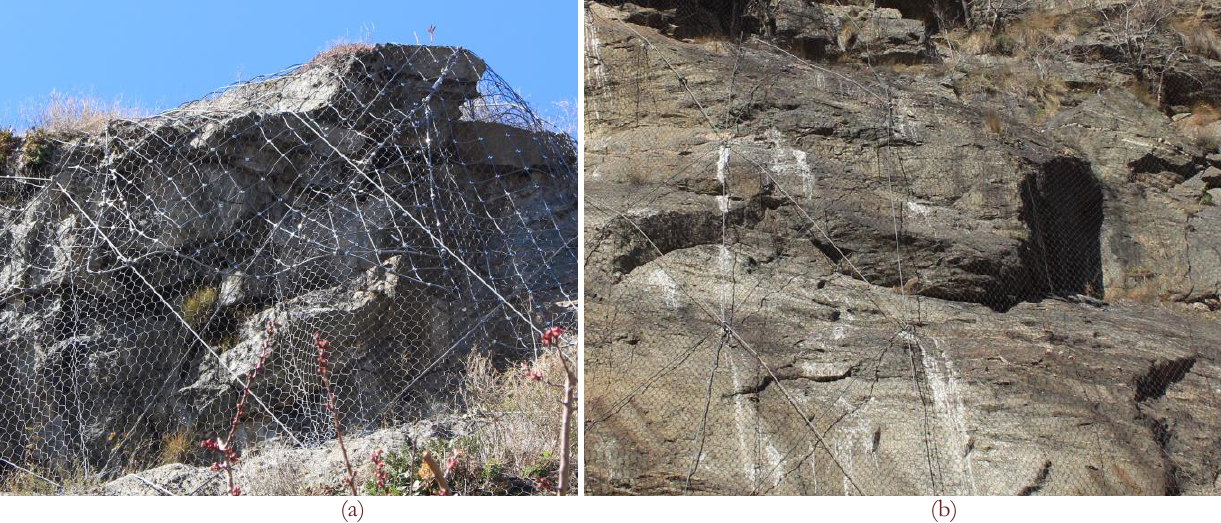
Figure 6: In (a) two mesh types are adopted; in (b) the simple and the reinforced drapery systems are adjacent in the same